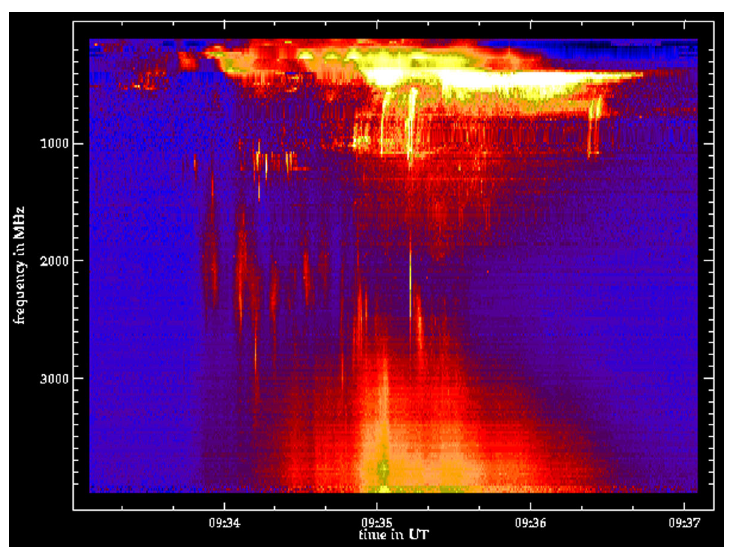
Fig. 30 Radio spectrogram observed by the Phoenix-2 spectro-polarimeter operated by ETH Zurich. At low frequencies ( top of image ), the radio emission is dominated by type III bursts and U bursts emitted by escaping electron beams and trapped electron beams. The brightest feature is a type V event, possibly caused by electrons left behind by unstable beams. At high frequencies ( bottom of image ) the synchrotron emission of mildly relativistic electrons (gyrosynchrotron) dominates, correlating well with hard X-rays. In the middle of the frequency range at about 800–2000 MHz, narrowband spikes of the decimetric type can be seen. Image adapted from Benz